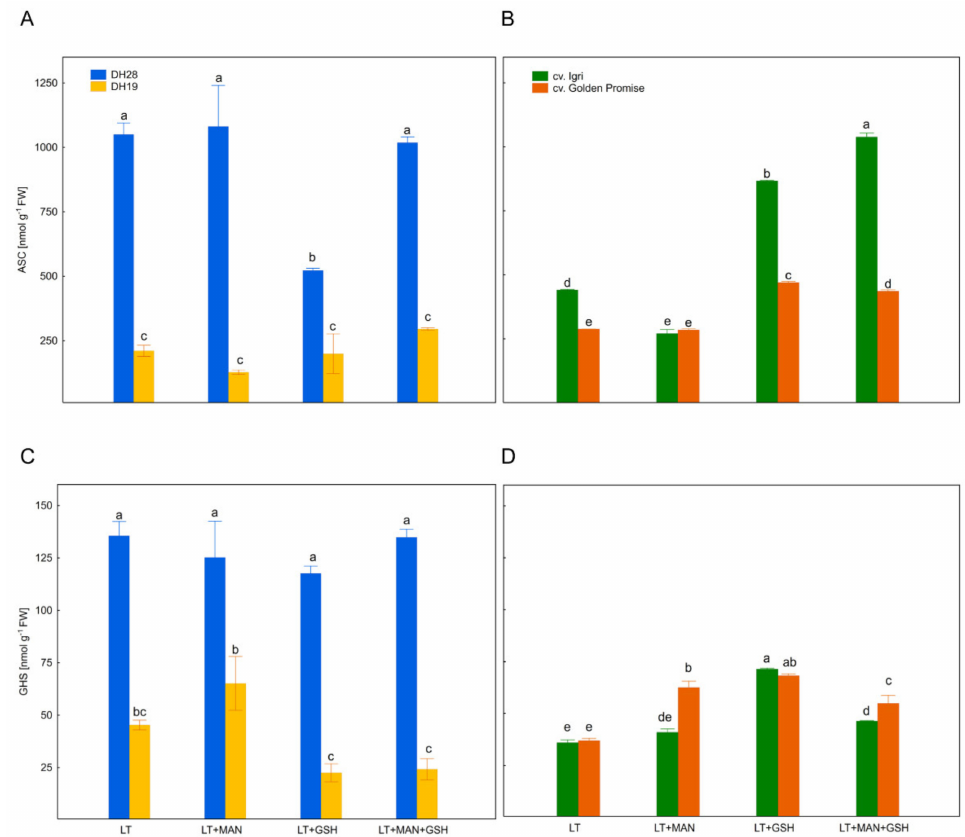
Figure 2. Reduced ascorbate (ASC) ( A , B ) and reduced glutathione (GSH) ( C , D ) contents in mi- crospores of two DH triticale lines (responsive DH28 and recalcitrant DH19) and two barley cultivars (responsive cv. Igri and recalcitrant cv. Golden Promise) isolated after various tiller pre-treatments. Data represent means of three biological replications ± SE. Values marked with the same letter do not differ significantly according to Duncan’s multiple range test ( p ≤ 0.05). Please see Figure 3, LT—low temperature tiller pre-treatment (21 days at 4 ◦ C); LT+MAN—low temperature tiller pre-treatment combined with the application of 0.3 M mannitol; LT+GSH—low temperature tiller pre-treatment combined with the application of 0.3 mM reduced glutathione; LT+MAN+GSH—low temperature tillers pre-treatment combined with the application of 0.3 M mannitol and 0.3 mM reduced glutathione. Two treatments (LT+GSH and LT+MAN+GSH) stimulated the accumulation of ASC in both barley cultivars and changed the ascorbate redox state (ASC/ASC+DHA) in mi- crospores of one or both cultivars (Figure 2B; Figure 3C). The effect of the LT+MAN treat- ment was genotype-specific as it reduced ASC accumulation exclusively in microspores of cv. Igri. All treatments increased GSH content in microspores of cv. Golden Promise (Figure 2D), but only LT+MAN application also increased the glutathione redox potential (GSH/GSH+GSSG; Figure 3D). Similarly, an increased level of GSH was detected in mi- crospores of cv. Igri after LT+GSH and LT+MAN+GSH treatments (Figure 2D), but it was not associated with a change in the GSH/GSH+GSSG ratio (Figure